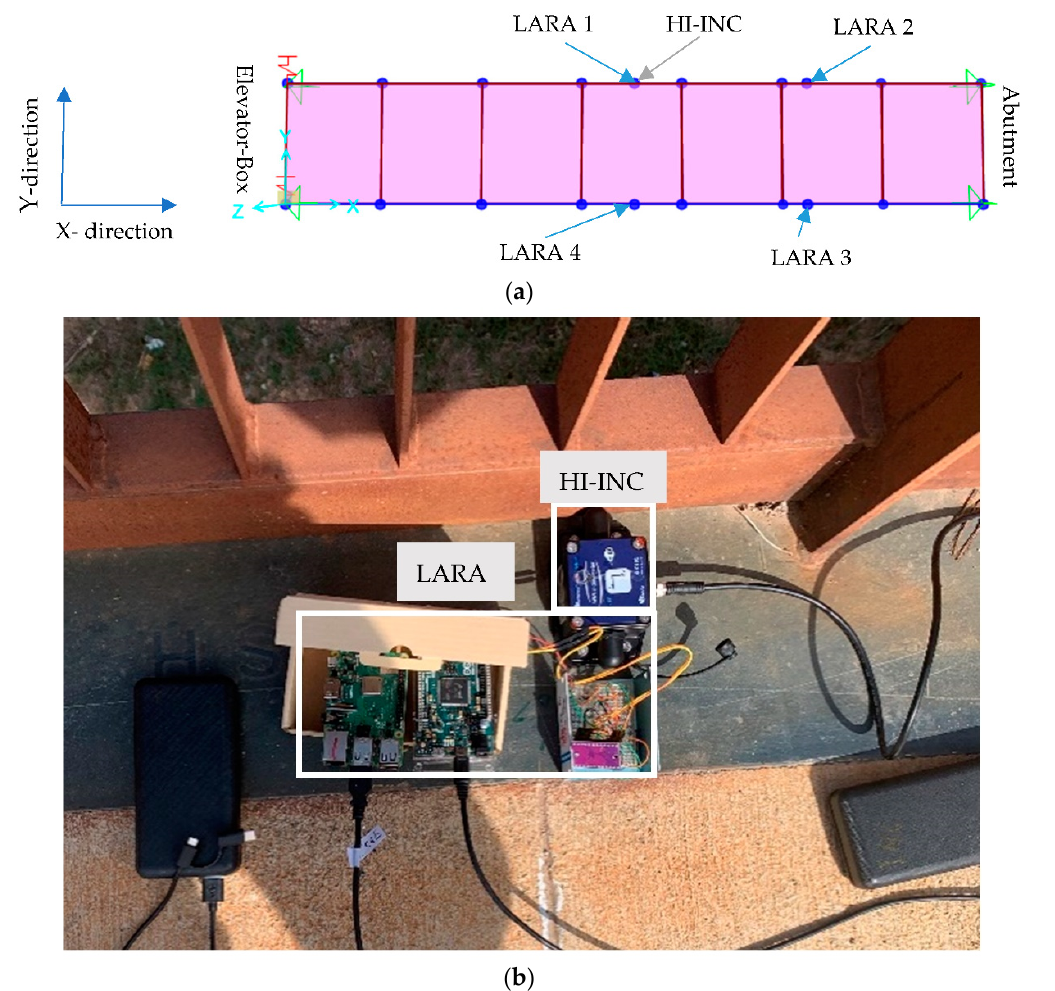
Figure 7. Digital model and position of the sensors: ( a ) SAP2000 model of the footbridge under study and allocation of the used sensors, and ( b ) instrumentation of the Polvorines footbridge.